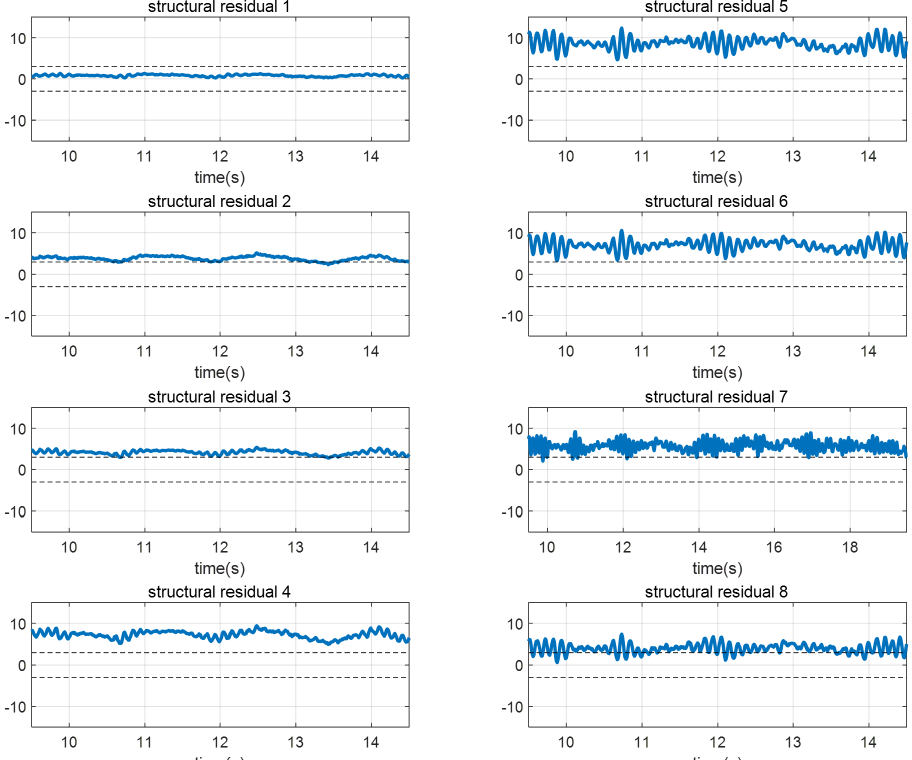
Figure 8. The experimental results of fault isolation with structural residual analysis in a steady-state cornering maneuver. The residuals indicate 1(FL), 2(FR), 3(RL), and 4(RR) for the steering actuator faults and 5(FL), 6(FR), 7(RL), and 8(RR) for the driving actuator